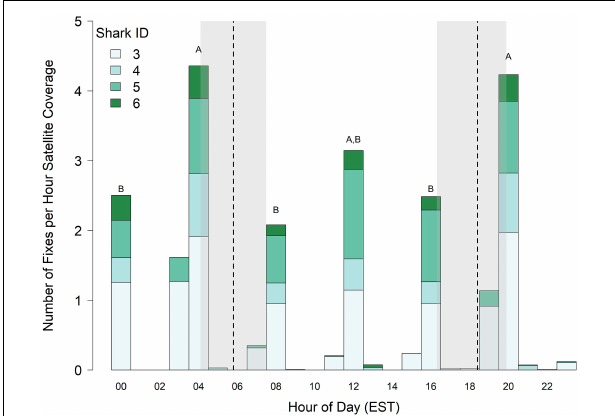
FIGURE 4 | Surfacing index (number of locations per hour of satellite time) of juvenile smooth hammerhead sharks. Vertical dashed lines and shading represent the minimum, mean and maximum times of sunrise and sunset experienced by sharks. Bars labeled with different letters differ at α = 0.05, and bars without letters were not included in statistical comparisons. Data only includes four sharks tagged in 2017. EST, Eastern Standard